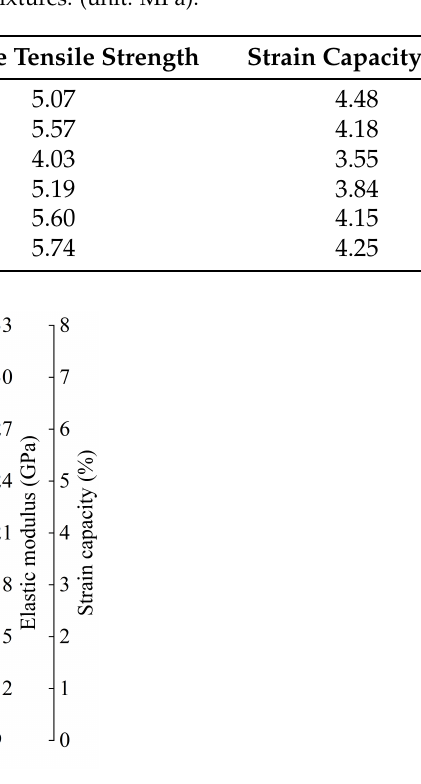
Table 5. Summarized tensile properties of ECC mixtures. (unit: MPa).